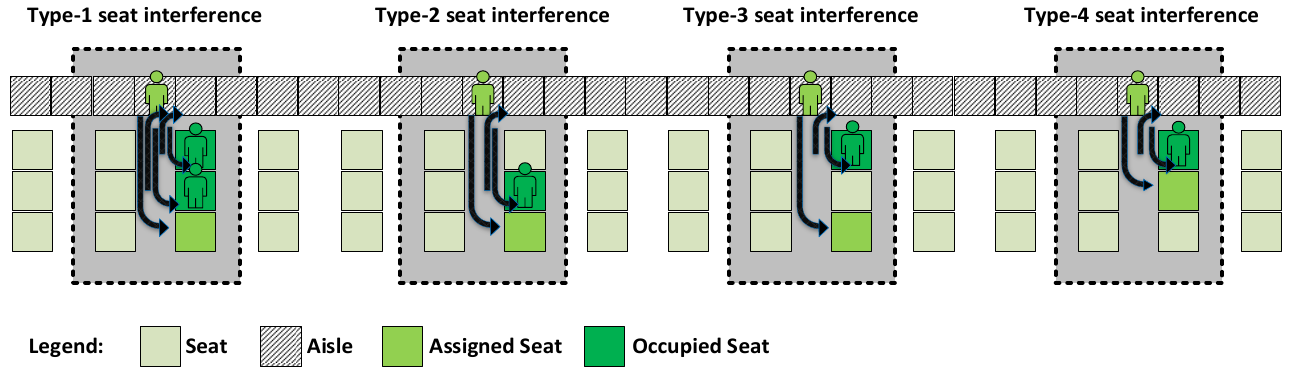
Figure 8. Types of seat interferences.